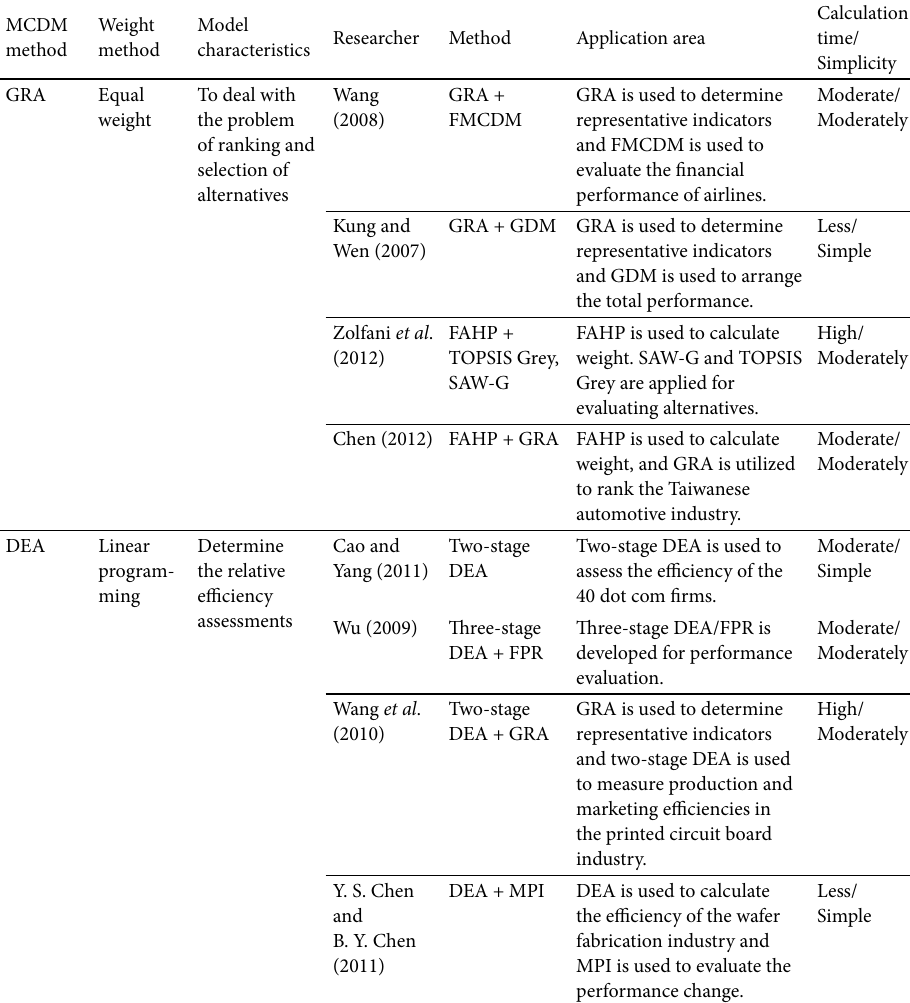
Table 1. Comparison the performance of GRA, DEA, VIKOR and proposed